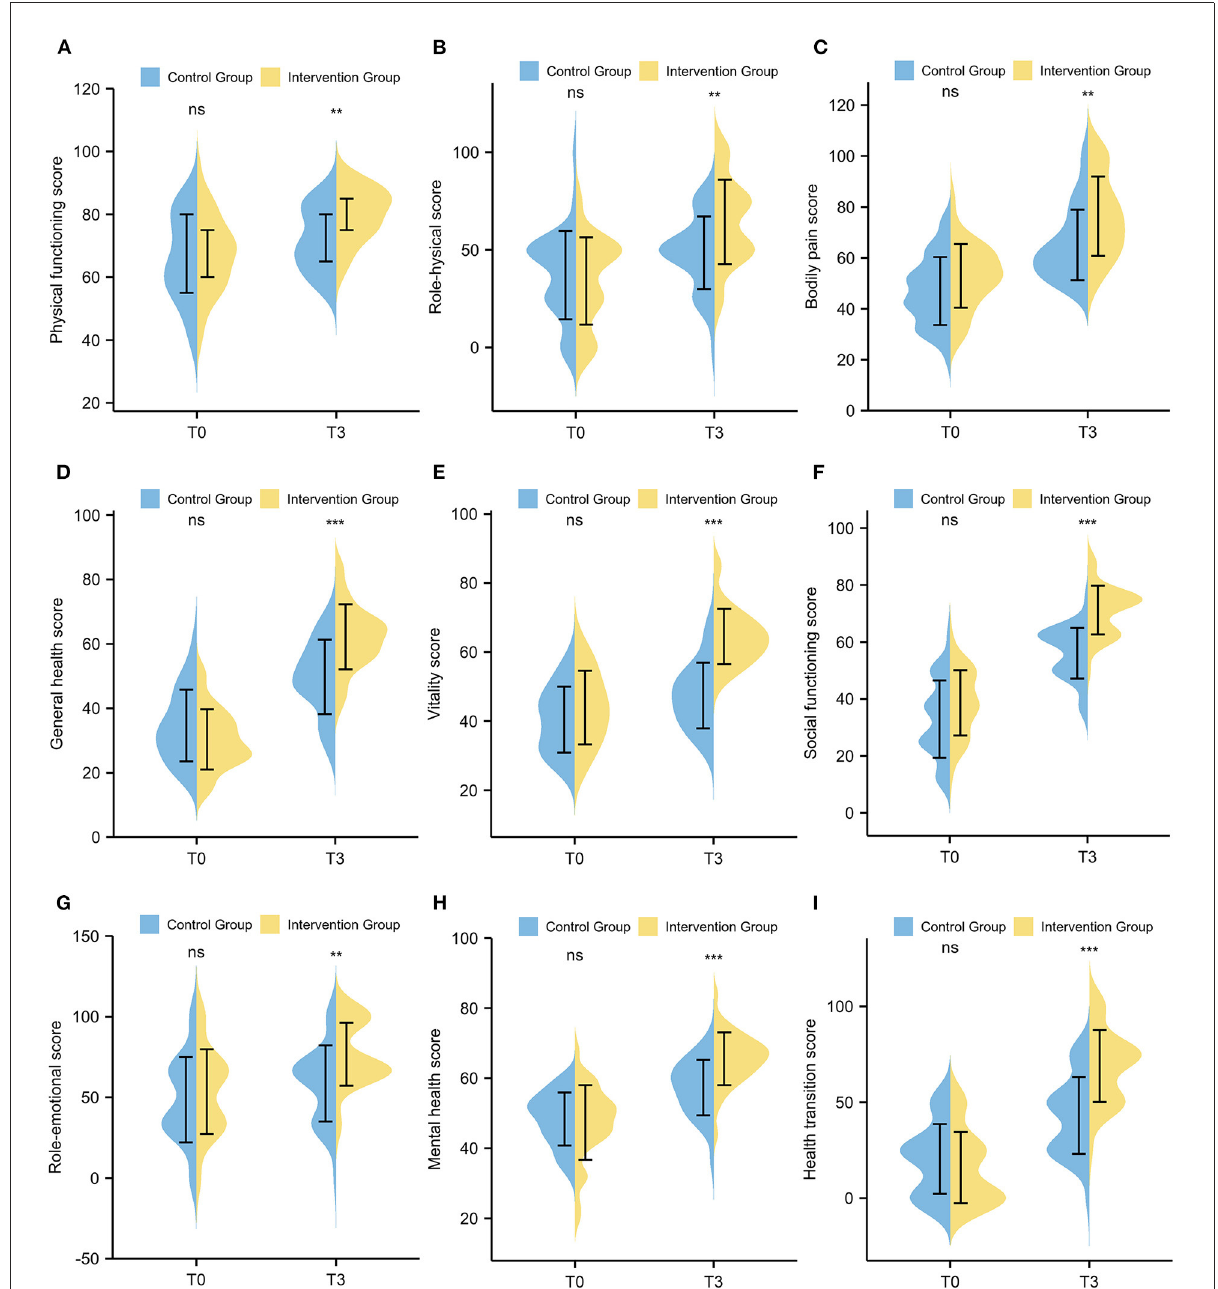
FIGURE4 Comparison of SF-36 scale scores between the intervention group and the control group. (A) Physical functioning; (B) Role physical; (C) Bodily pain; (D) General health; (E) Vitality; (F) Social functioning; (G) Role emotional; (H) Mental health; (I) Health